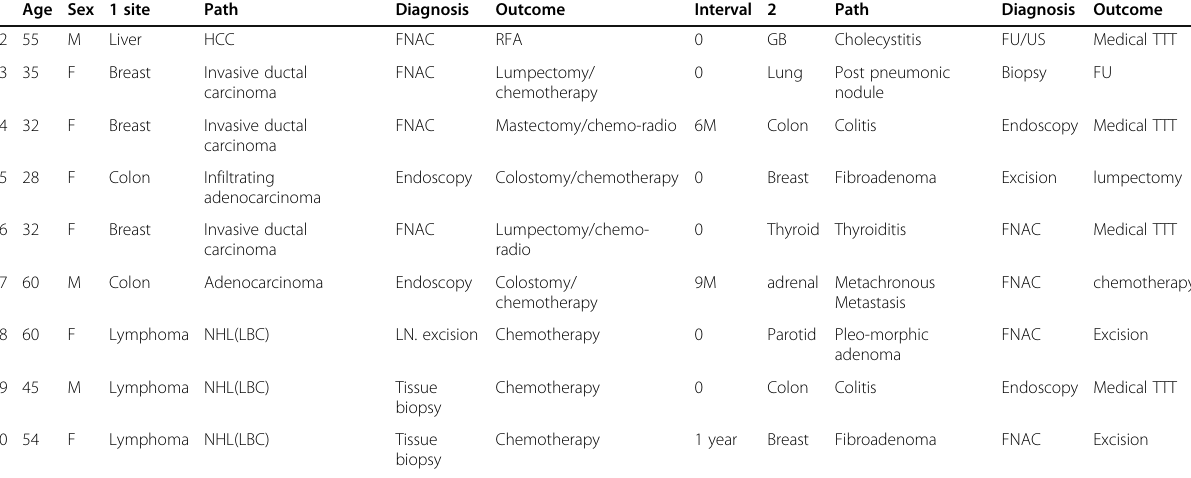
Table 2 False-positive cases characteristics, pathology of index tumors, and additional primary malignancies, diagnostic procedures, and outcomes